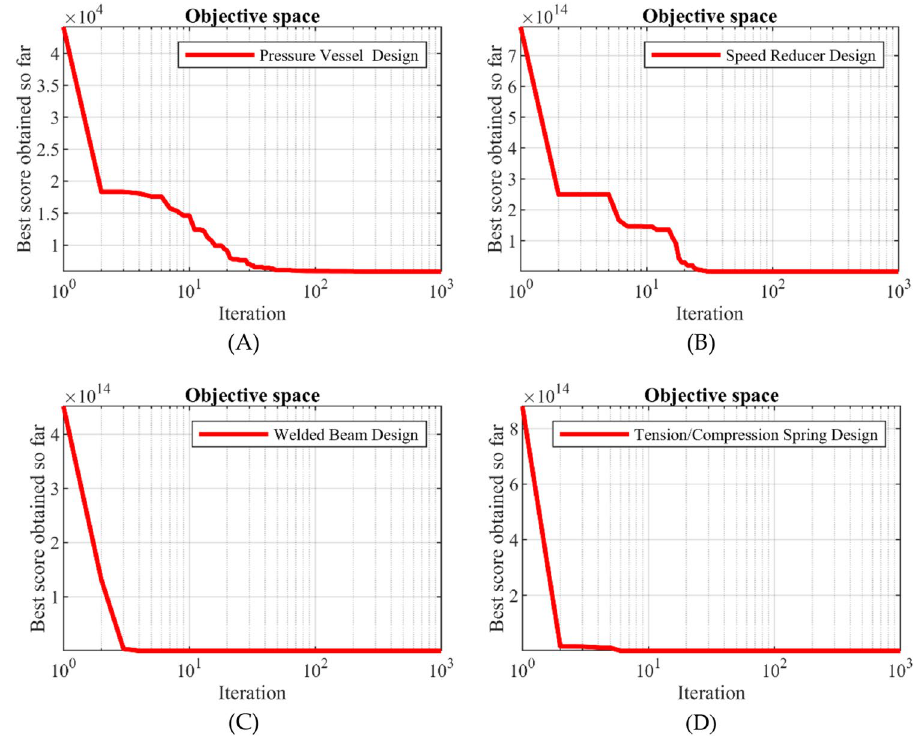
Figure 5. Convergence curves of STBO on four real-world